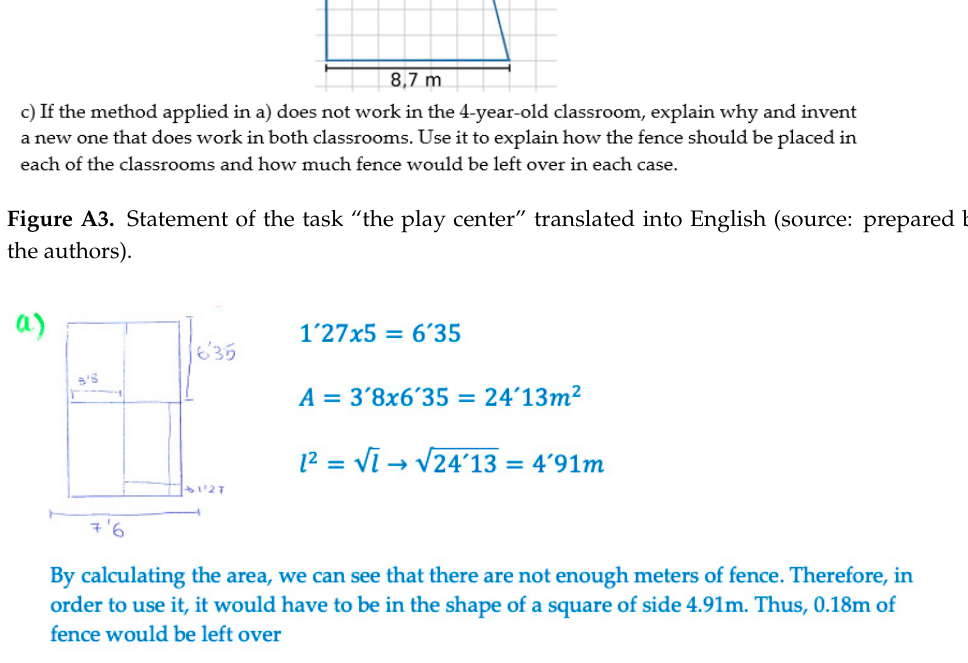
Figure A4. Translation into English of the written production for the task “the play center”. Answer to question a) (source: prepared by the authors).